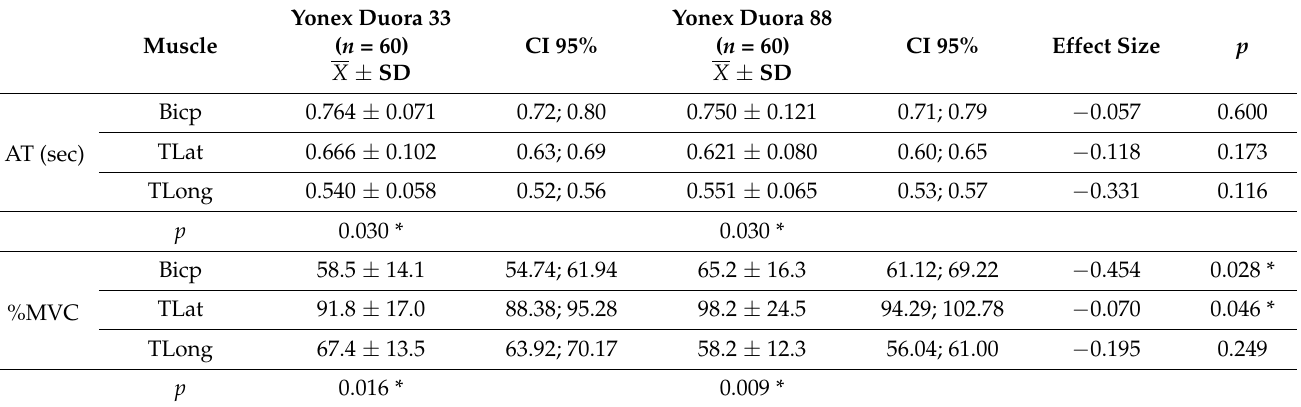
Table 2. %MVC and AT for each of the rackets and respective comparisons.